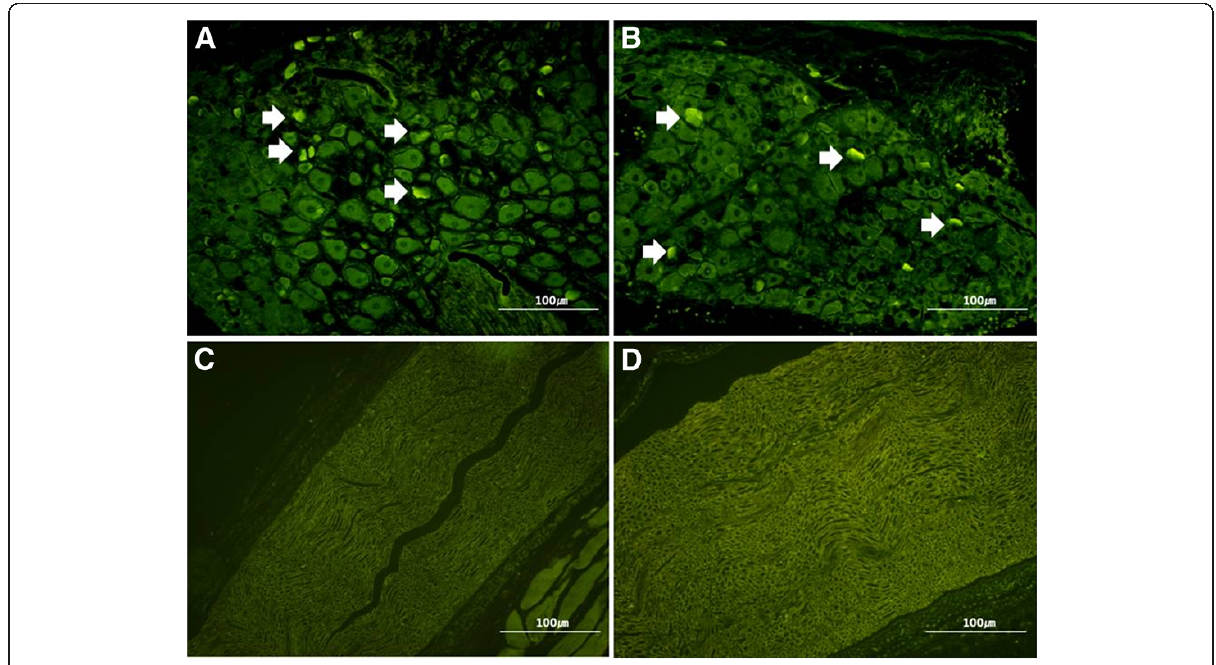
Figure 5 The comparison of apoptotic-featured cells between DRG and sciatic nerve in both groups. TUNEL staining shows the increased number of apoptotic-featured cells in dorsal root ganglia of two groups ( A . Group I, B . Group II, White arrow), but apoptotic-featured cells were not easily found in sciatic nerve of two groups( C . Group I, D . Group II), x 200 magnification. The white arrow marks indicate the apoptotic- featured